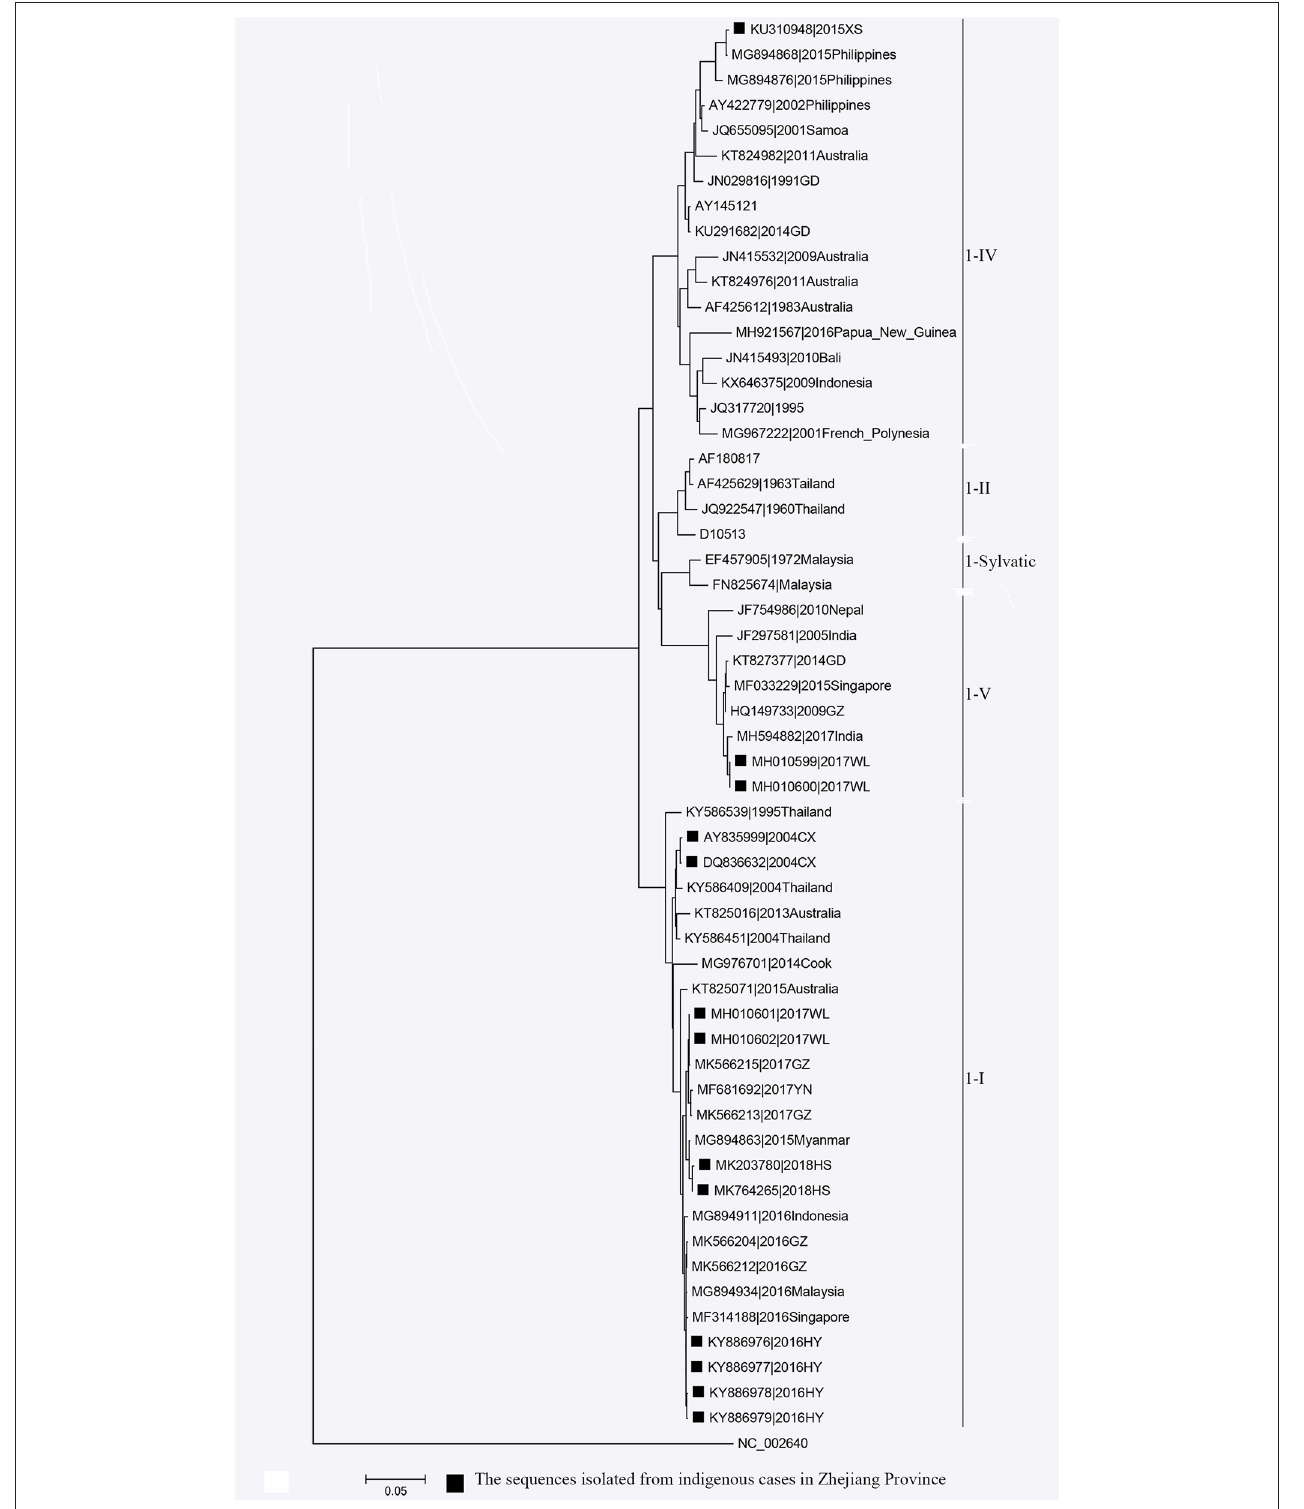
FIGURE 4 | Phylogenetic tree of DENV-1 strains based on the E gene.